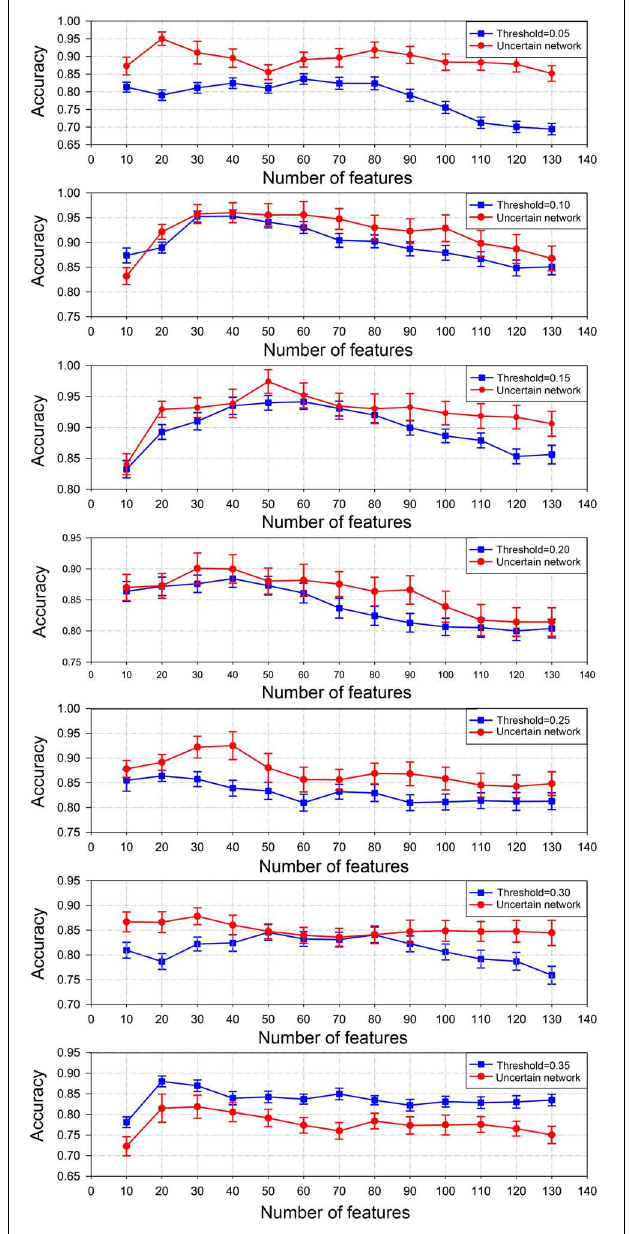
FIGURE 7 | Classification performance using the weighting method to map discriminative subgraph features of the certain brain network to the uncertain network. The ordinate denotes the accuracy, and the abscissa indicates different feature